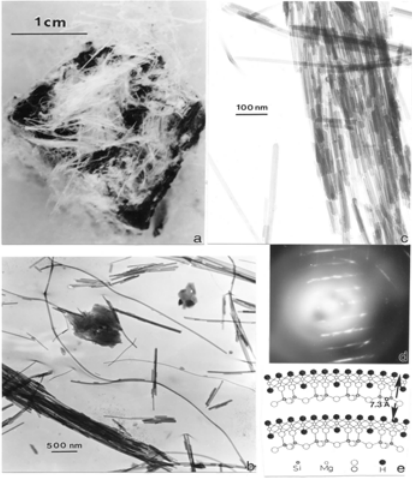
Figure 1: Chrysotile asbestos nanotubes. (a) Small mineral sample form large mine in Quebec, Canada. (b) TEM image of individual nanotubes, broken fragments, and small aggregated bundles [42]. (c) Magnified TEM image of aggregated chrysotile nanotubes [41]. (d) SAED pattern corresponding to the aggregate in (c) showing streaking of diffraction spots. (e) Curved layer schematic tube sections spaced 7.5 Å. (After De Souza Santos